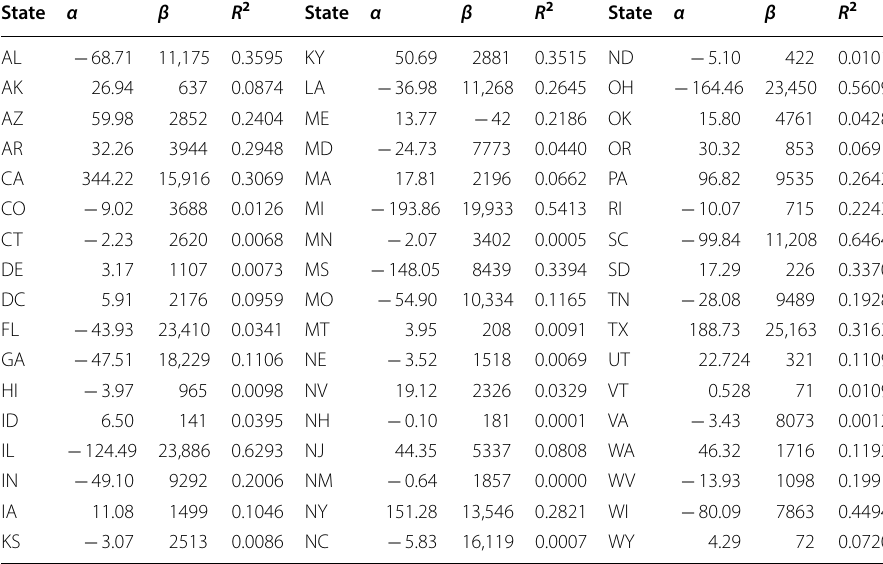
Table 4 Coefficients α , β , and R 2 of the linear regressions for Gonorrhea cases State